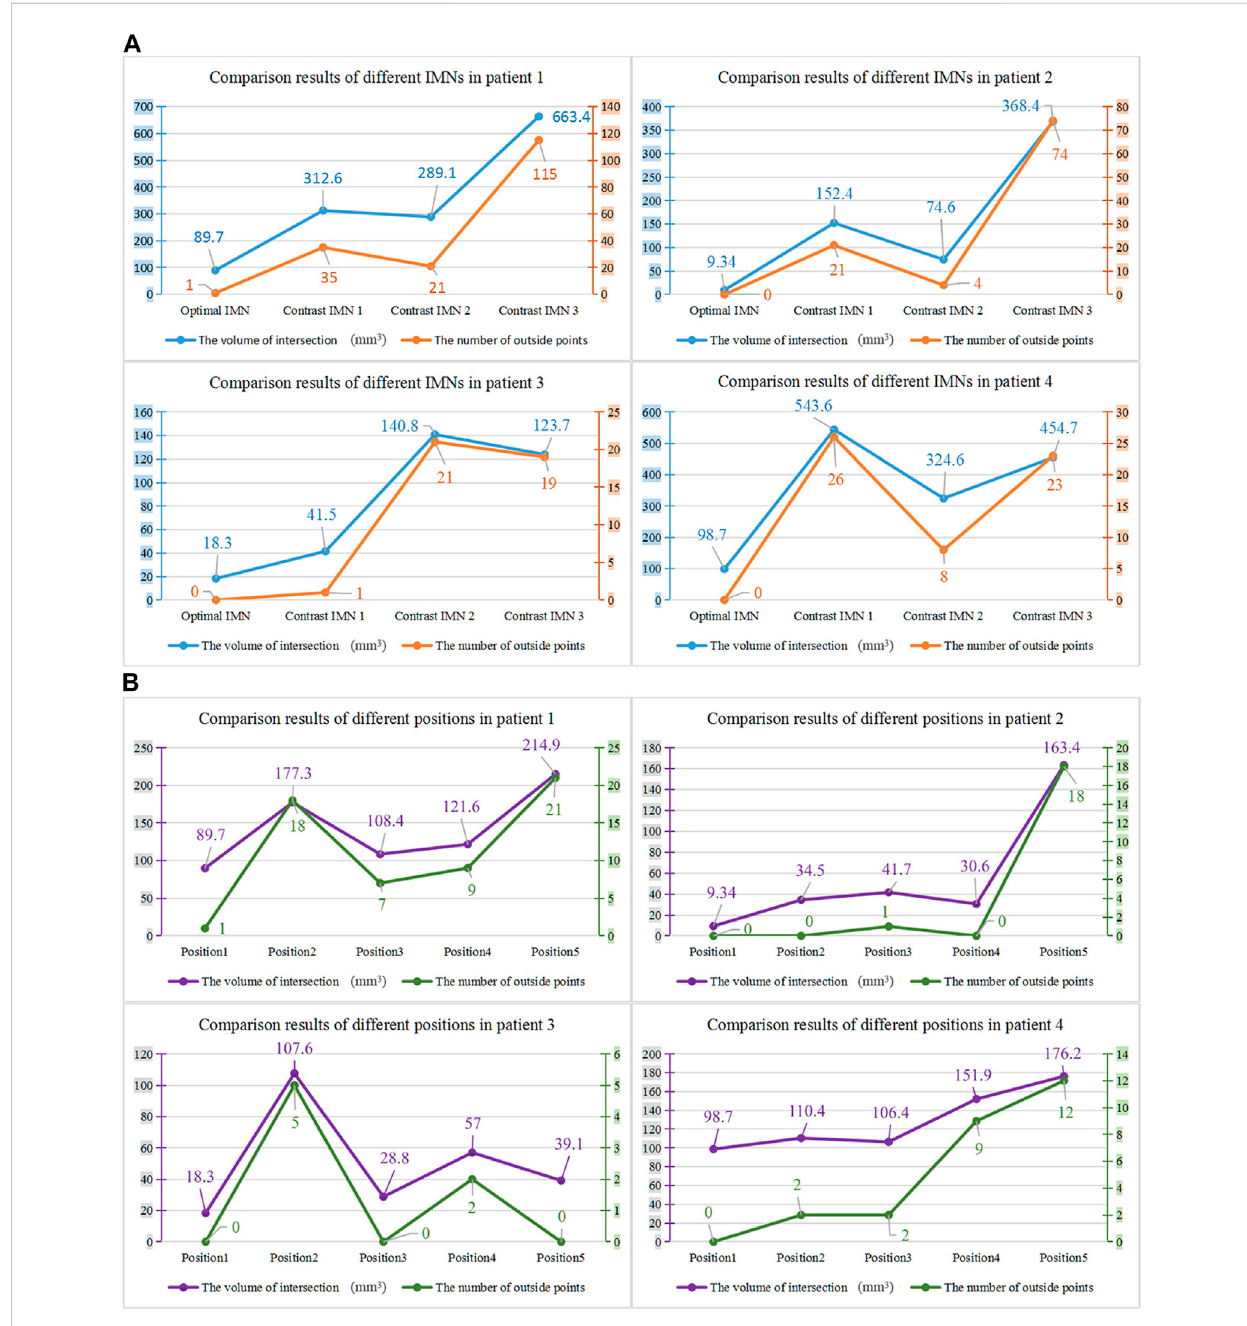
FIGURE 7 (A) Comparison results of different intramedullary nails for the four patients. (B) Comparison results of different registration positions of the four